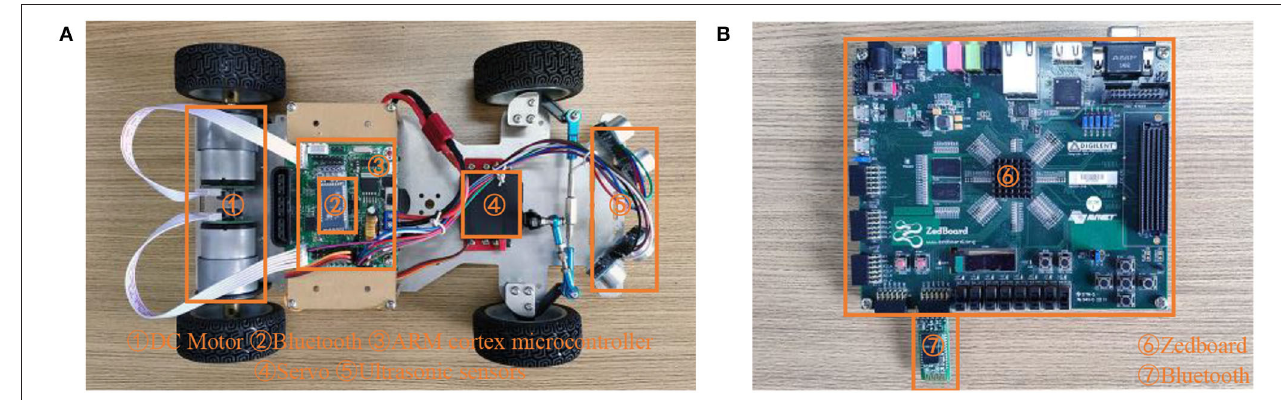
FIGURE 5 | The hardware platform to implement the proposed SNN, where (A) is the mobile robot and (B) is the Zedboard development